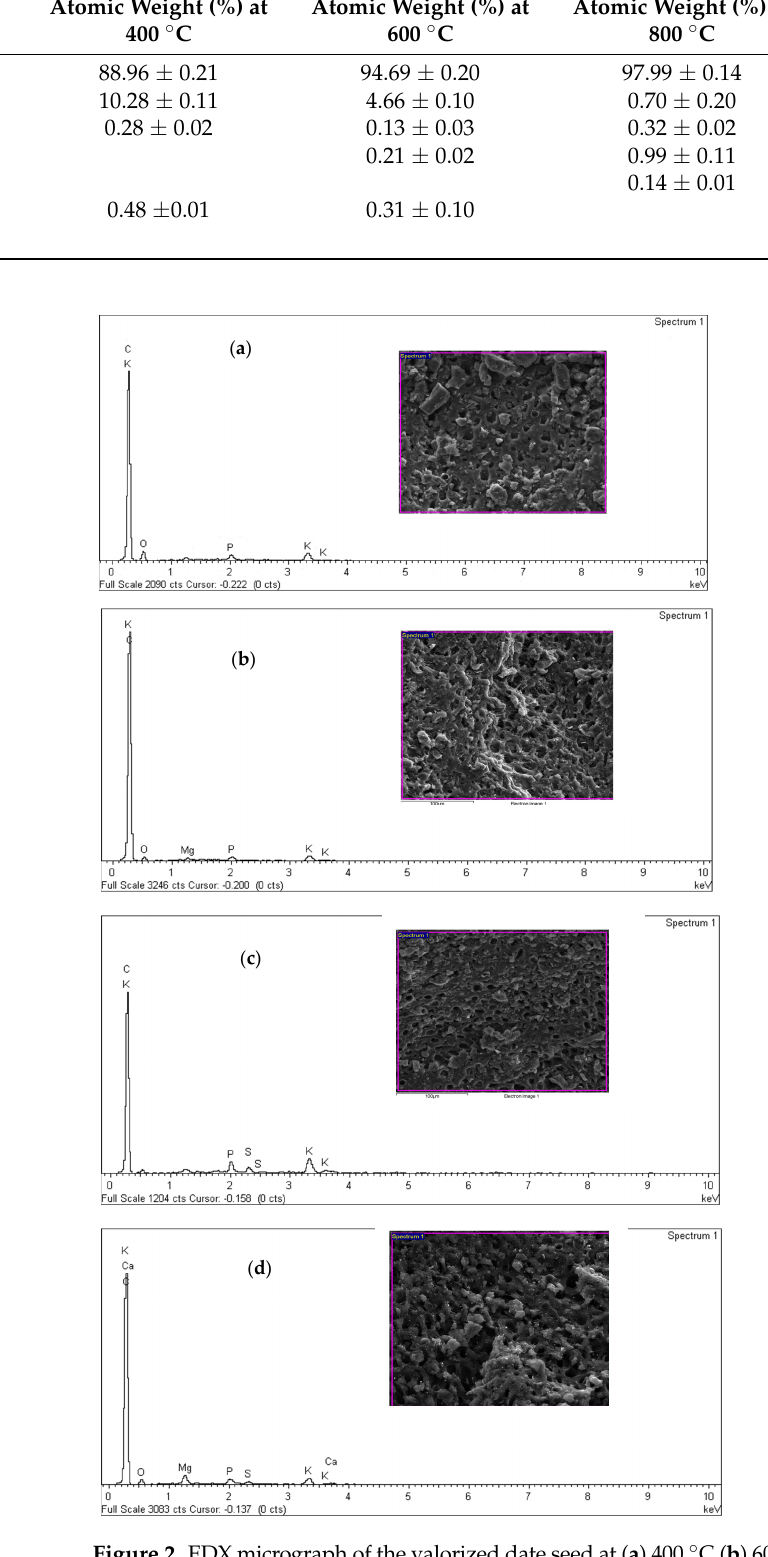
◦ C ( b ) 600 ◦ C ( c ) 800 ◦ C, and ( d ) 1000 ◦